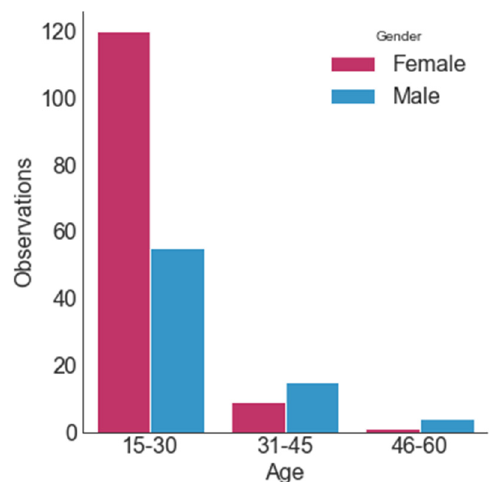
Figure 5. Sample age distribution by gender.